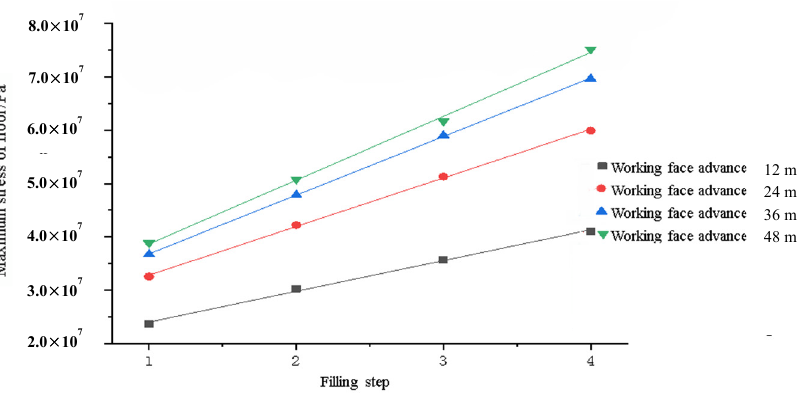
Figure 9. The relationship between the maximum stress of the paste-filling working face floor and the filling step under different advancing distances.